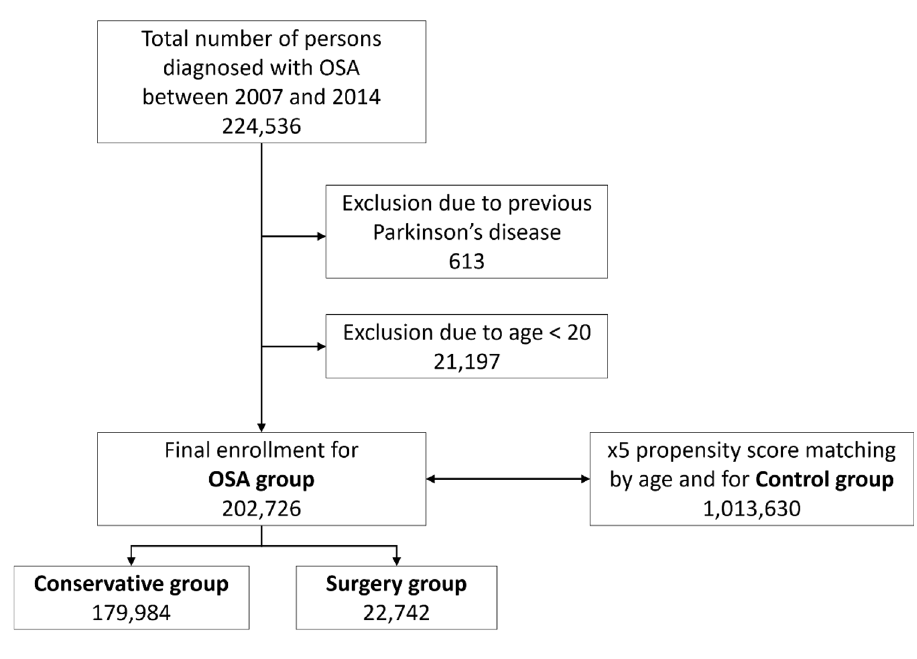
Figure 1. Patient enrolment